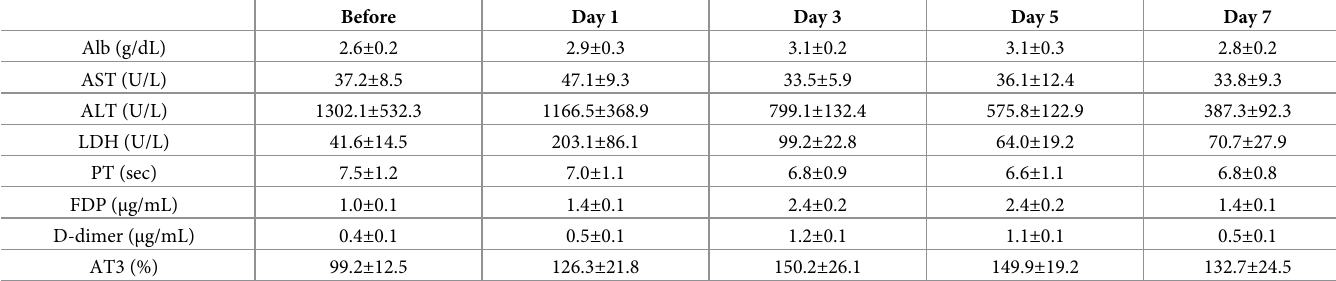
Table 2. Clinical laboratory test results in the safety